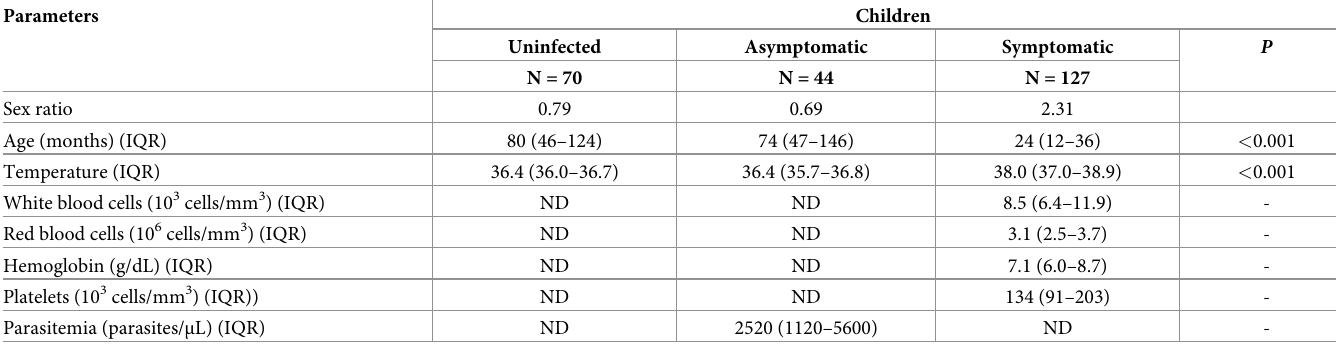
Table 1. Demographical and clinical parameters of the children included in the study.